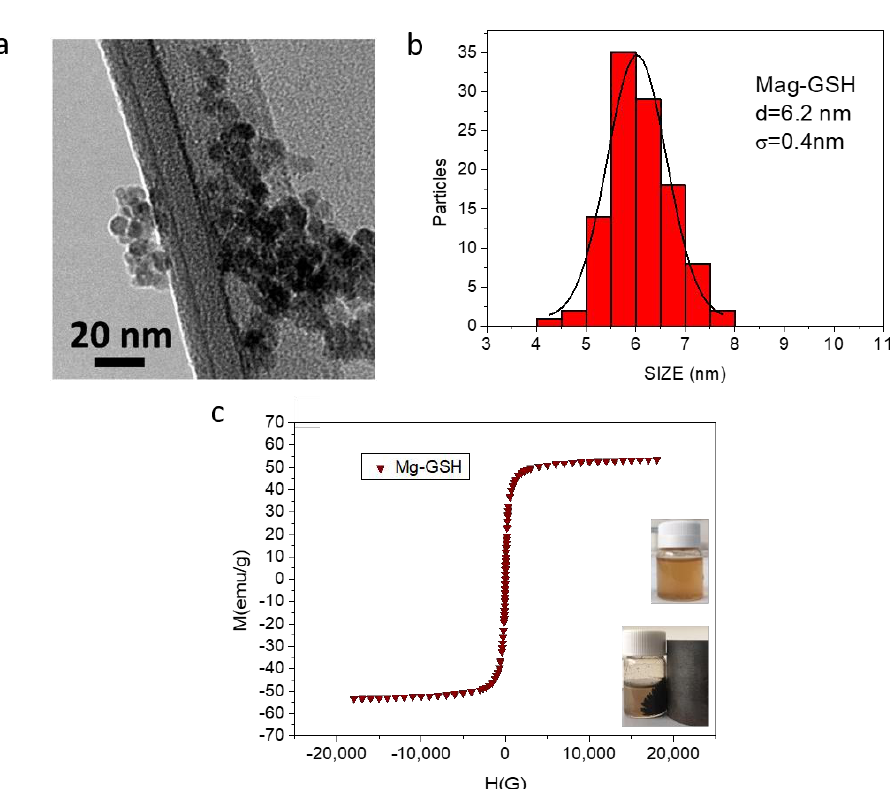
Figure 3. Bright field TEM (BF-TEM) micrograph ( a ), as well as the histogram displaying the particle size distribution ( b ) size distribution ( b ) of Mag-GSH NPs. Magnetization curve of Mag-GSH NPs ( c ). The inset in of Mag-GSH NPs. Magnetization curve of Mag-GSH NPs ( c ). The inset in this figure shows a digital photo image of Mag- GSH NPs placed in the absence and presence of a magnet located close to the vials.